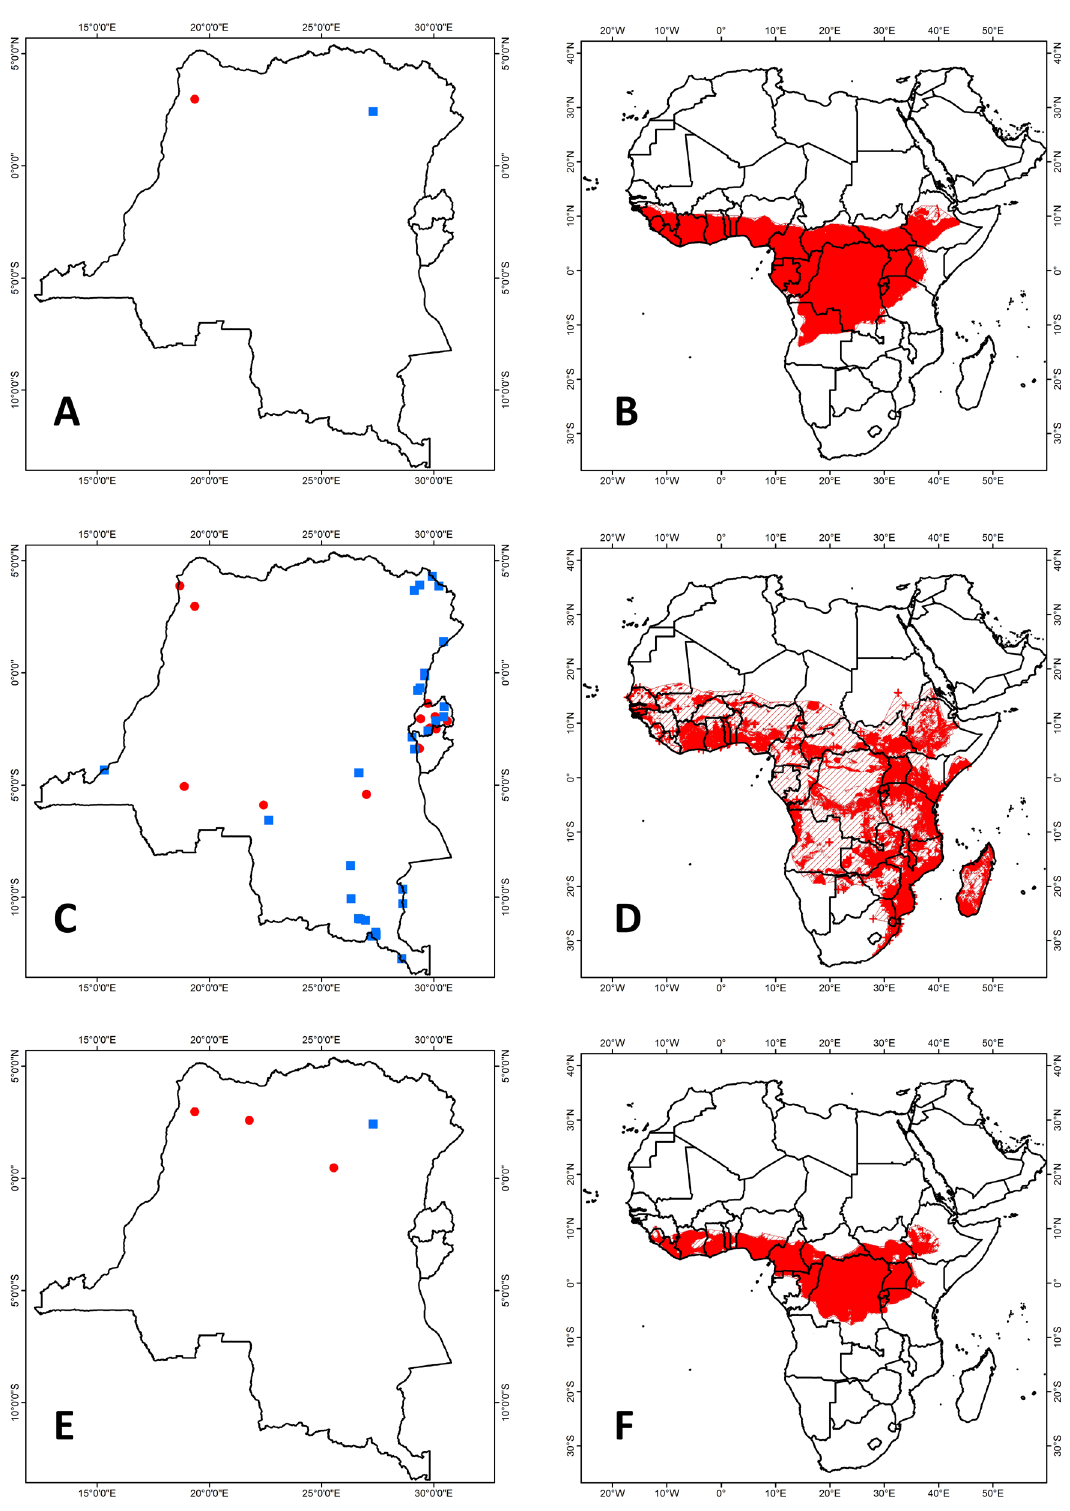
Fig. 27. Distribution maps. A–B . Chaerephon russatus J.A. Allen, 1917. C–D . Mops (Mops)